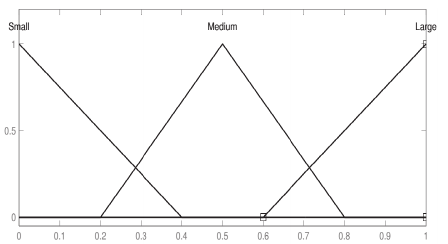
Fig. 2. Membership functions for desirability- fuzzy reasoning